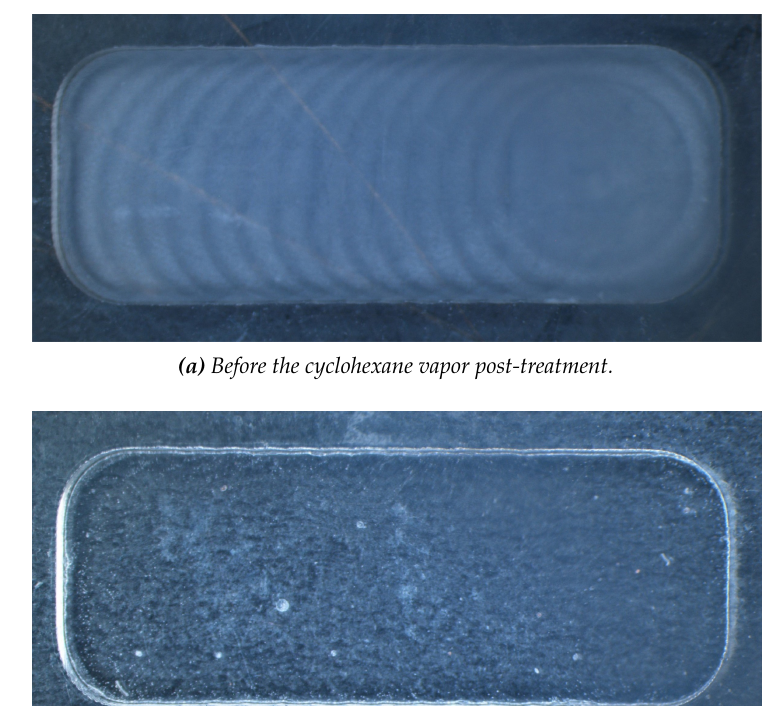
Figure 8. AFM measurements ( a – c ) and SEM images ( d – f ) showing the effect of a cyclohexane vapor post-treatment on the surface roughness of milled COC. Panel ( a , d ) shows the pristine COC surface. ( b , e ) Shows the milled surface. ( c , f ) Shows the cyclohexane vapor post-treated surface. The scale bars in the SEM images are 2 µm.